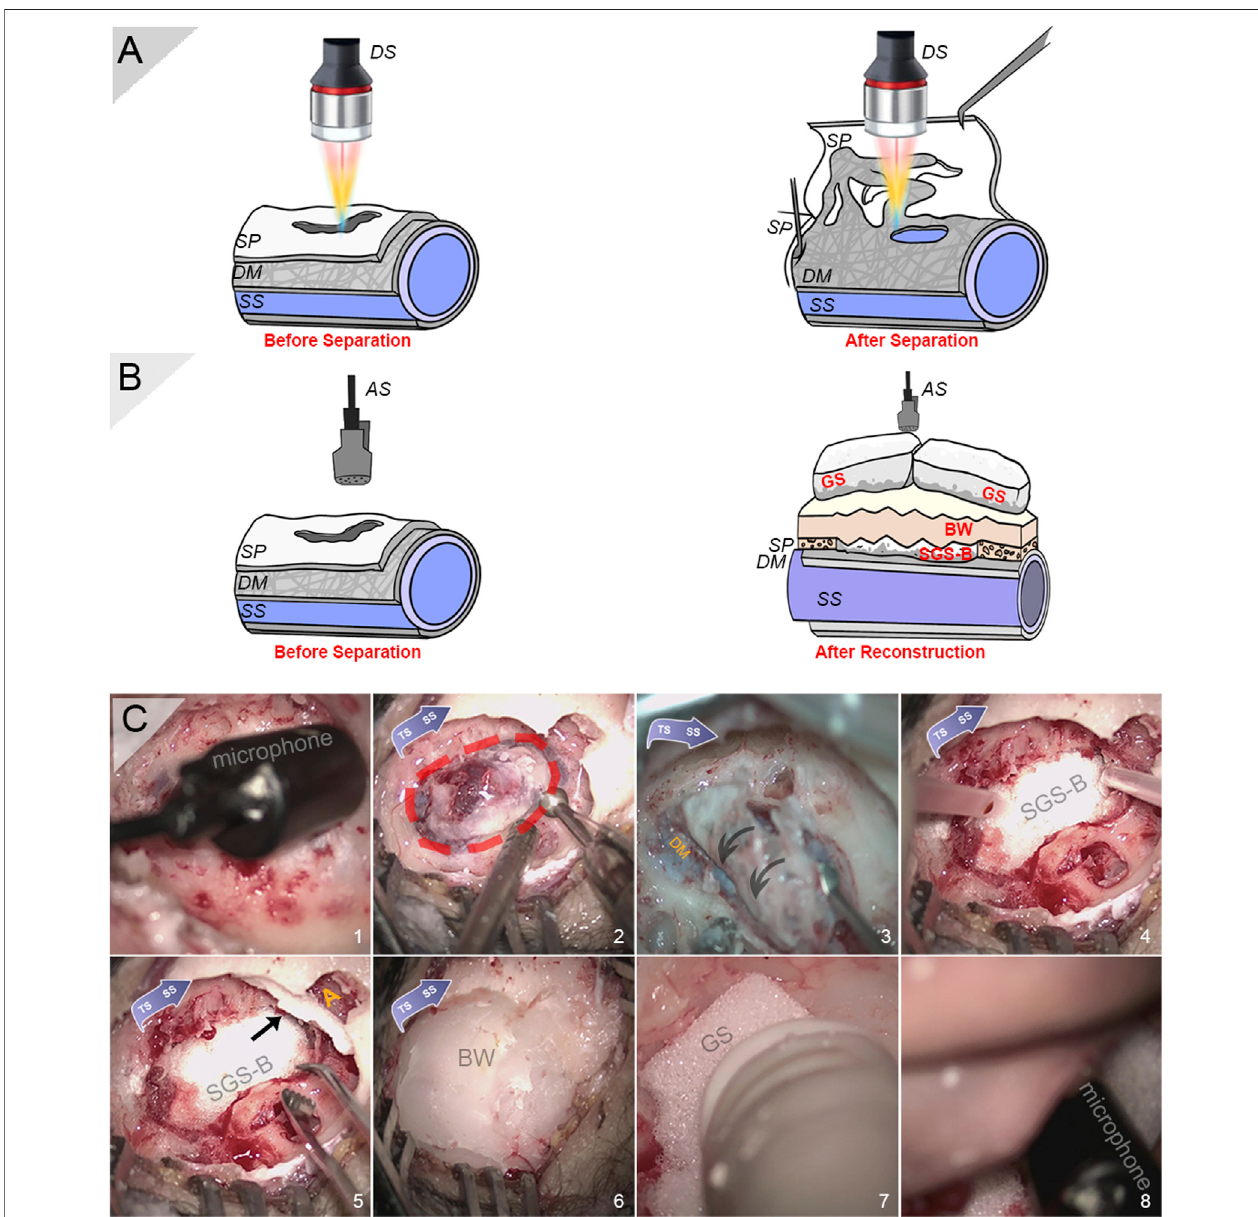
FIGURE 2 | Intraoperativephotographsand schematic diagrams for sensing applications. (A) Schematicdiagram ofintraoperativedisplacement sensing applications before and after separation of the vascular and osseous walls. (B) Schematic diagram of intraoperative acoustic sensing applications before and after reconstruction of sigmoid plate. (C) Intraoperative photographs of installation of condenser microphone, harvest of sigmoid plate specimen, and solidi fi ed gelatin sponge – bone wax repair technique (in sequence). (1) Intraoperative insertion of a condenser microphone after the exposure of sigmoid plate dehiscence to record PT. Note that the actual recordingtookplaceaftertheauricleandperiostealskin fl apwasreapproximated.(2)Harvestofthedehiscentbonyplate.Notethatarectangularregionwasskeletonizedto relievethetightly fi xatedspecimen. (C) Removalofthedehiscentsigmoidplate.Notethattheduramater fi xatesthevascularwalltightlytotheconcavesurfaceofthesigmoid plate. (D) A squished solidi fi ed gelatin sponge-brick fi xated using surgical glue to cover the transverse – sigmoid junction. (E) Another squished piece of solidi fi ed gelatin sponge-brickblocking the opening ofthe antrum (yellow A)alongside piecesofsolidi fi edgelatin sponge fi lling the air cells. (F) A thick layer ofbonewax appliedtocover and sealdeadspacesinsidethemastoidcavity. (G) Theporous,softgelatinsponge fi llingtheremnantdeadspace. (E) MonitoringwhetherPTpersistsaftermultilayerresurfacing and quanti fi cation of surgical ef fi cacy before closing the incision. DS indicates displacement sensor, SP indicates sigmoid plate, DM indicates dura mater, SS indicates sigmoid sinus, AS indicates acoustic sensor, SGS-B indicates solidi fi ed gelatin sponge-brick, GS indicates gelatin sponge, and BW indicates bone wax.